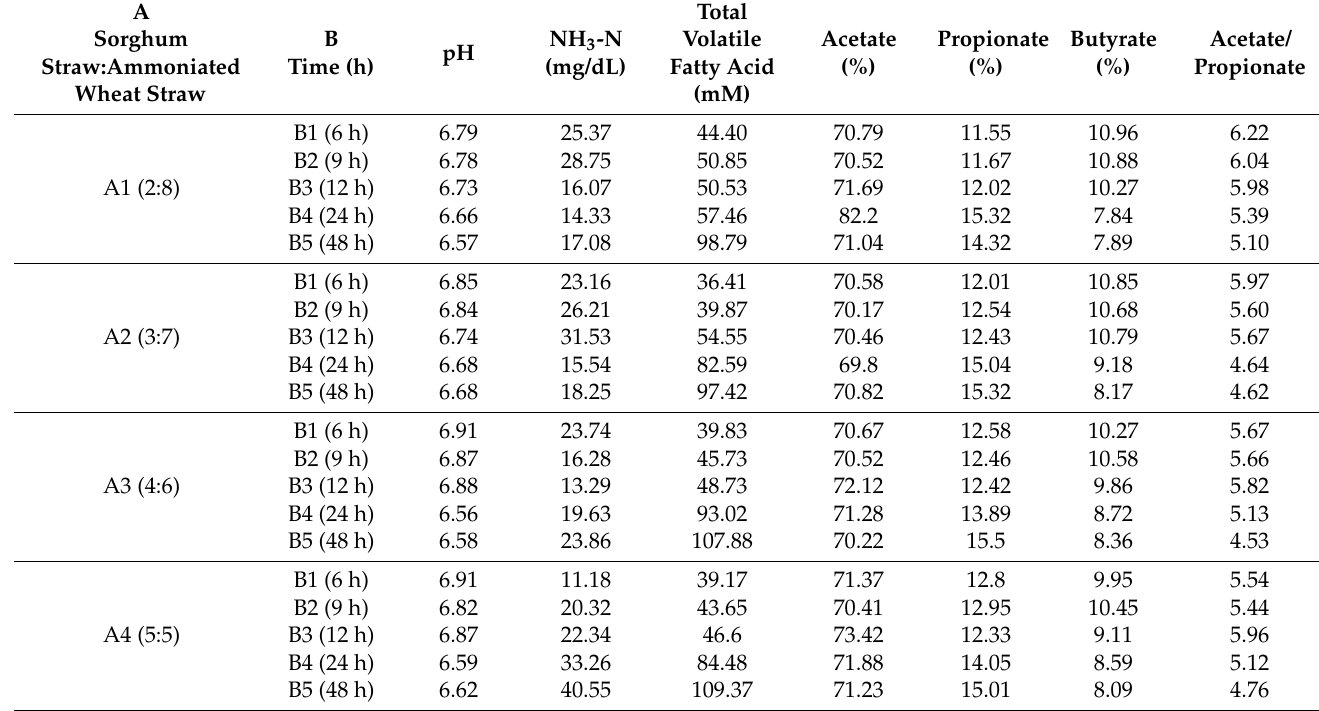
Table 7. Effects of different proportions of sorghum straw and wheat straw on fermentation parame- ters in vitro at different time